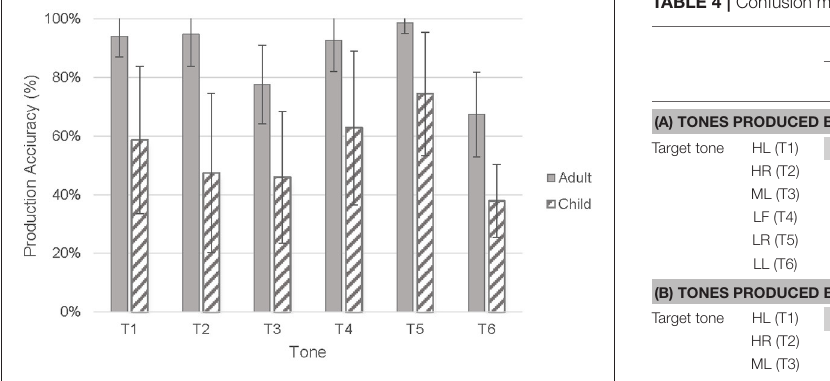
FIGURE 3 | Tone production accuracy of children and adults.